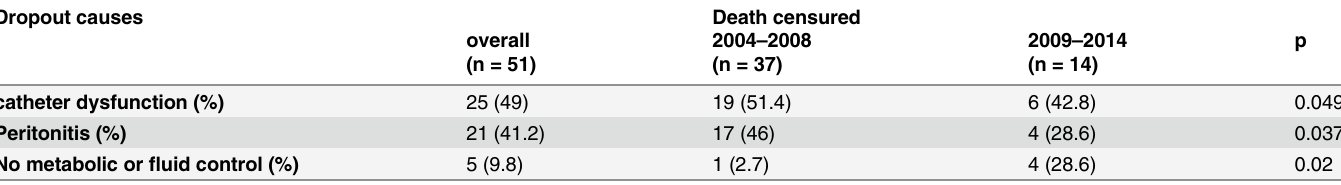
Table 4. Dropout causes according to time period. Dropout